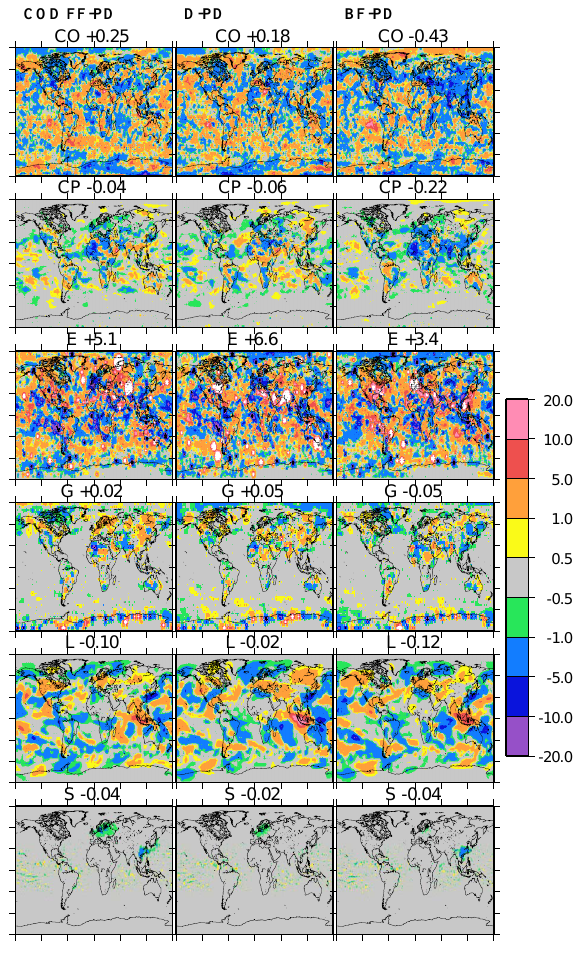
Fig. 4. Difference in annual mean cloud optical depth (COD) be- tween the fossil fuel (left), diesel (middle) and biofuel (right) reduc- tion experiments and the full simulation. Each row is one model.